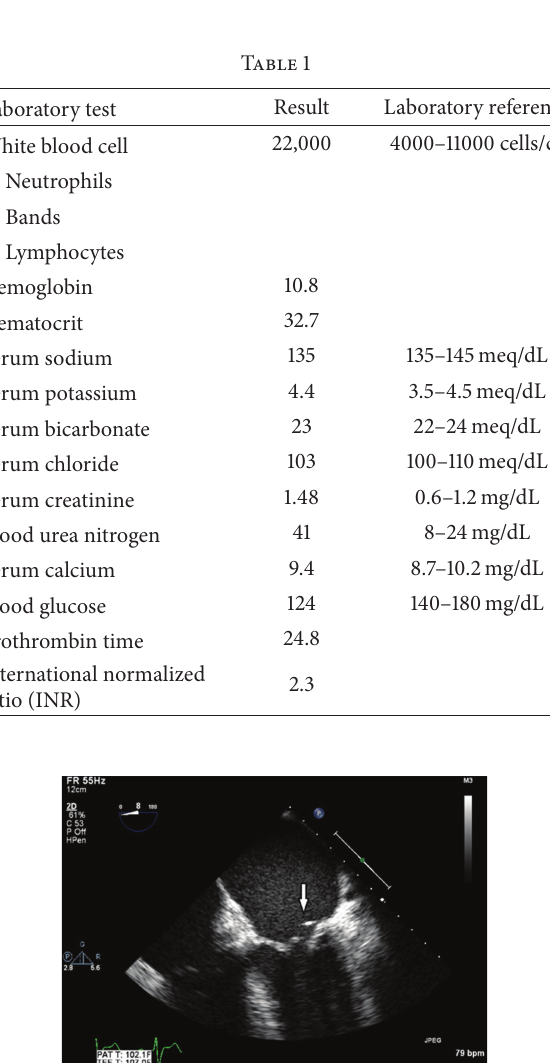
2/6 systolic murmur at the mitral area without any